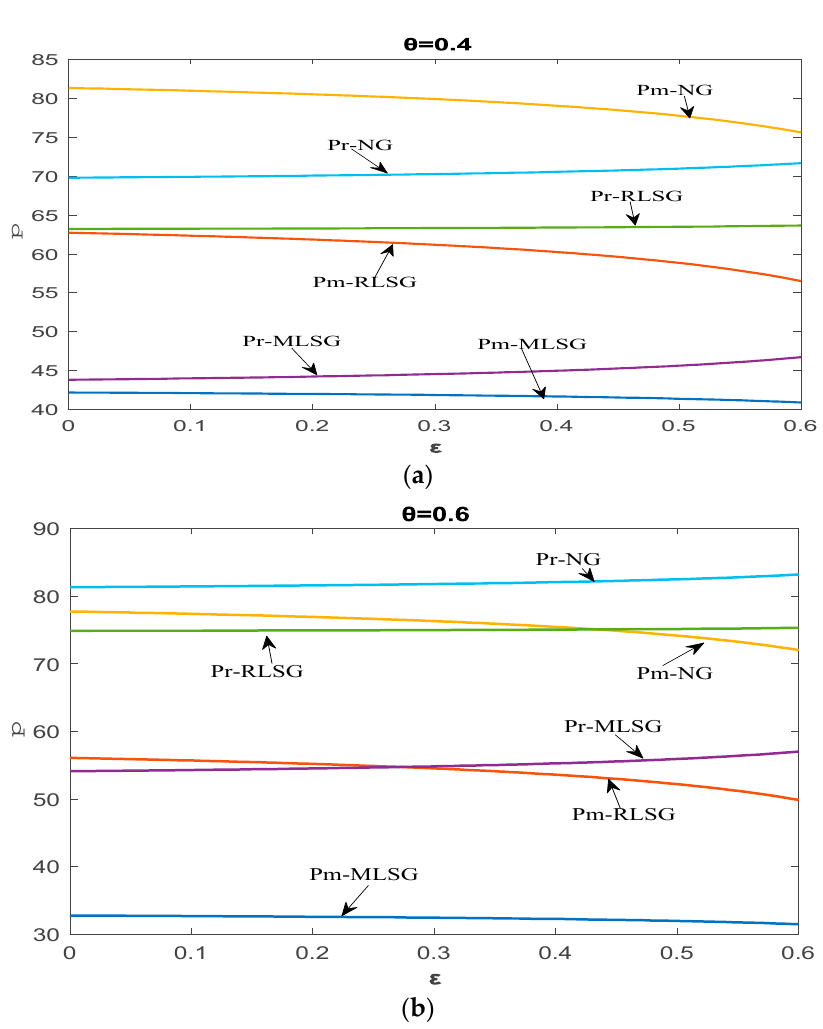
Figure 5. Comparison of pricing under decentralised decision-making models: ( a ) low consumption channel preference 𝜃 and ( b ) high consumption channel preference 𝜃 .